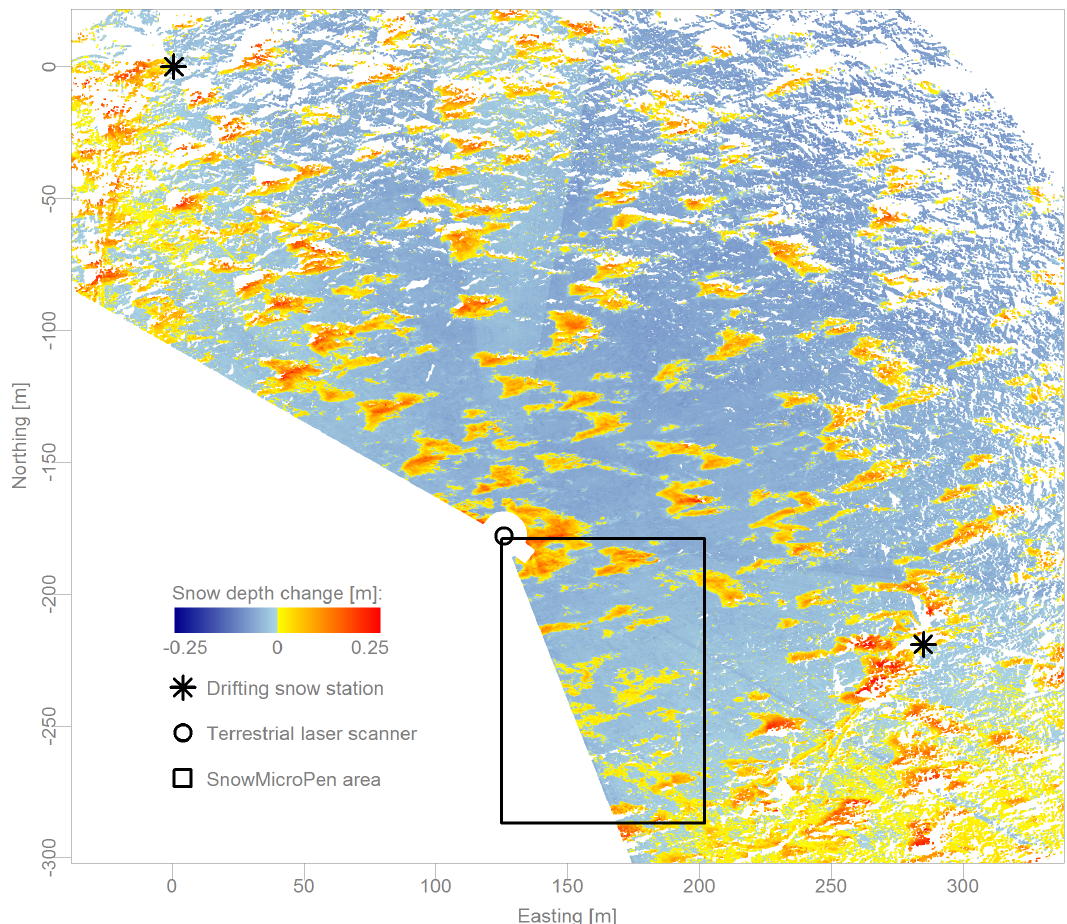
Figure 1. Overview of the study area. The asterisks show the location of the drifting snow stations. The circle indicates the position of the terrestrial laser scanner. All SnowMicroPen measurements were acquired inside the rectangle. A detailed view of this area is shown in Fig. 3. The colors show the snow depth changes between the scans acquired on 18 December 2016 and 11 January 2017. The yellow and red depositional features distributed over the whole area are newly formed barchan dunes. Erosion areas, indicating that old snow is exposed at the surface, are shown in shades of